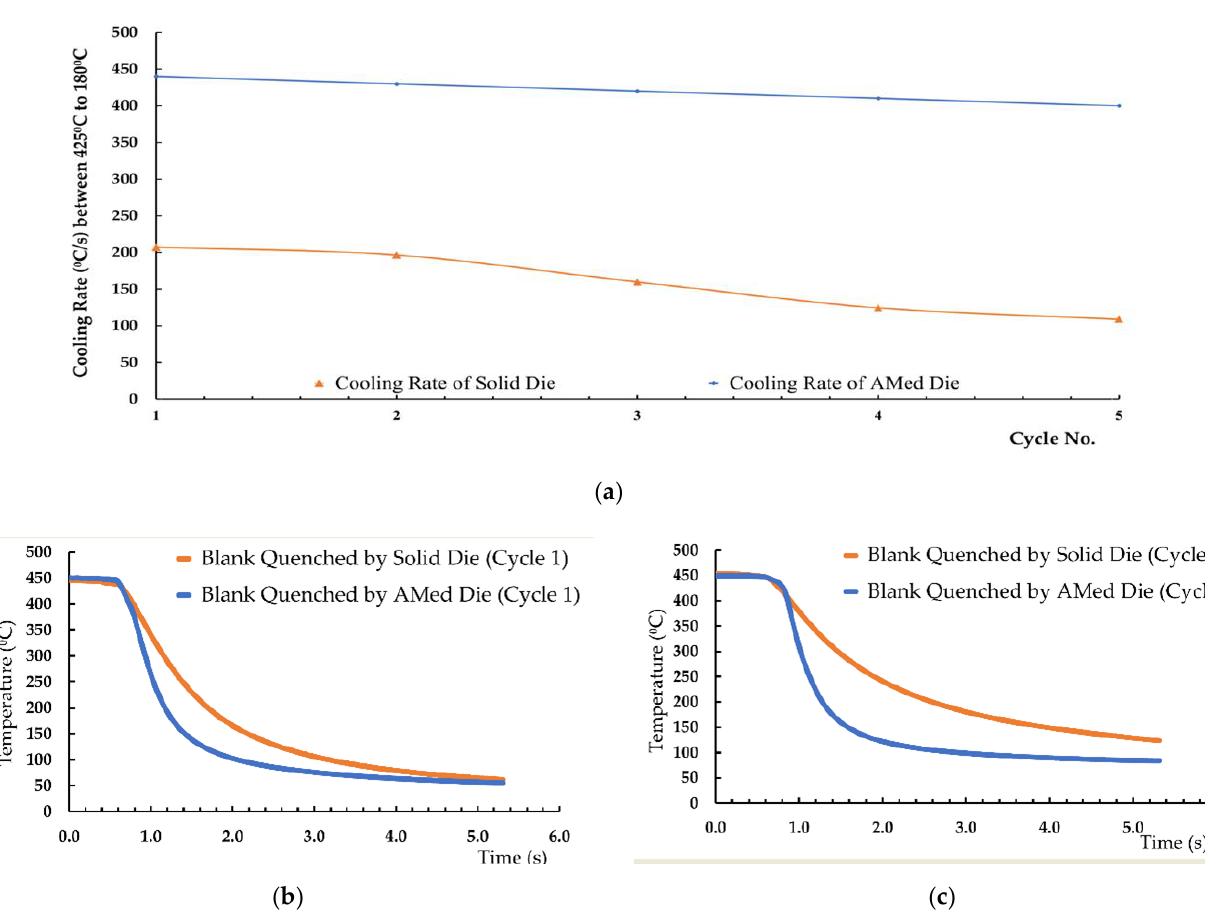
Figure 6. ( a ) Cooling rates of the blank for each cycle; ( b ) blank temperature evolution — 1st cycle; ( c ) blank temperature evolution — 5th cycle . ( c ) blank temperature evolution—5th